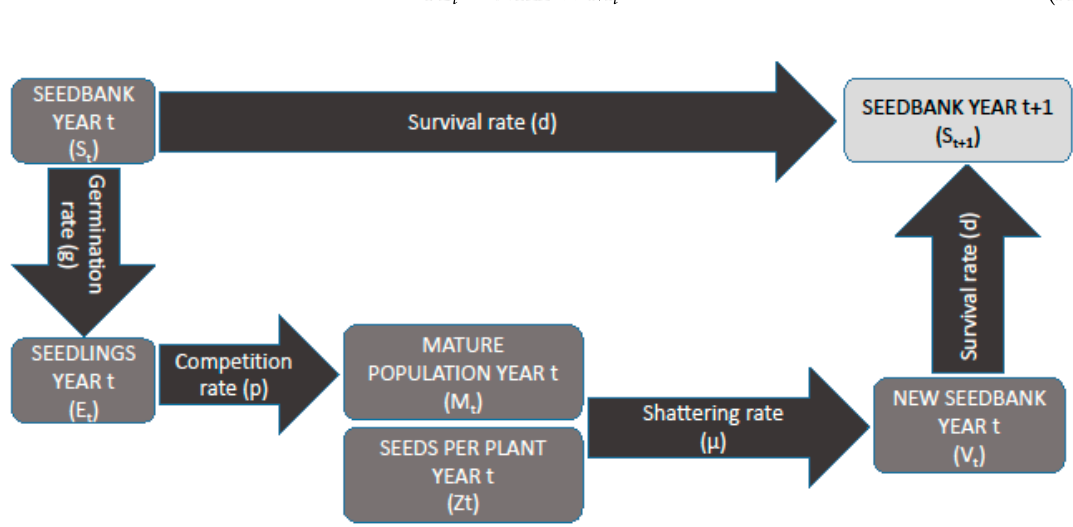
Figure A1. Graphical depiction of the dynamic red rice growth model. 134